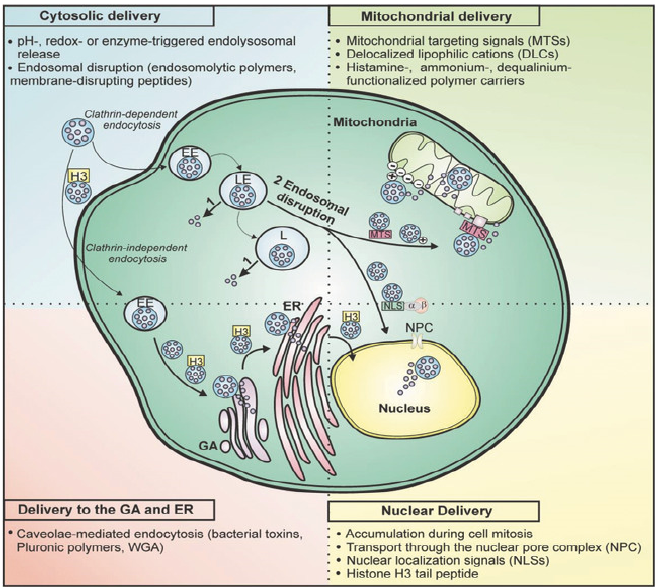
Figure 2. Overview of approaches that have been developed to control intracellular delivery of nanocarriers. Reprinted from ref. [43] with permission from John Wiley & Sons